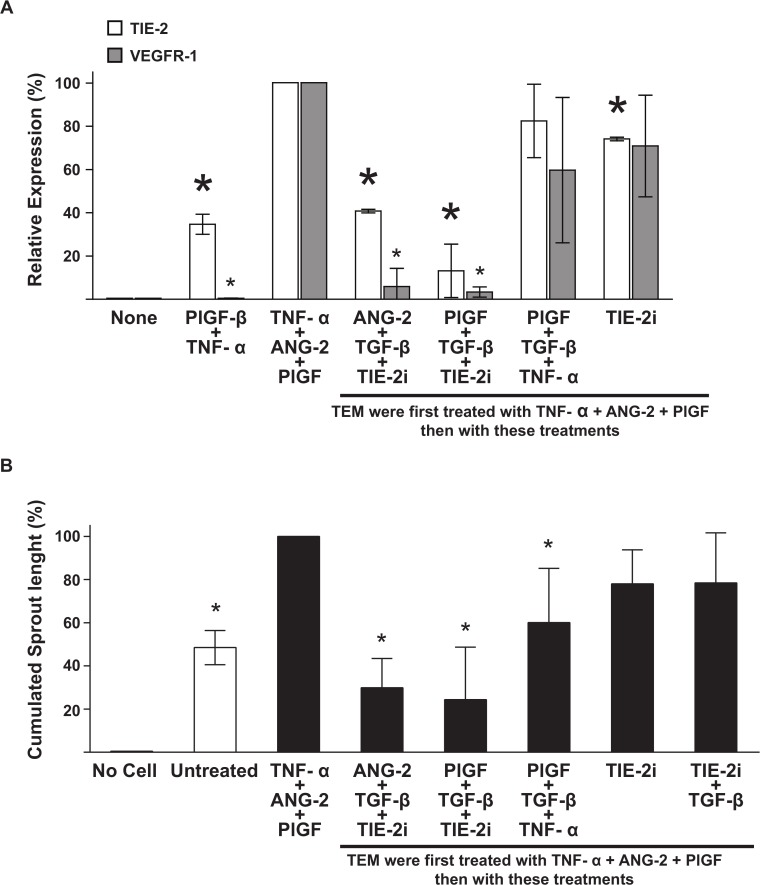
Experimental validation of in silico predicted treatments using ivdTEM.TEM differentiated in vitro were exposed to the treatments predicted in silico and their changes in TIE-2 and VEGFR-1 expression (A) and pro-angiogenic activity (B) measured by flow cytometry and in vitro angiogenesis sprouting assay respectively. The impact of inhibitory treatments was examined on ivdTEM previously treated with TNF-α/PlGF/ANG-2 (panels A and B). Significant variations (P < 0.05) are indicated with an asterisk. In panel A, small and large asterisks referred to VEGFR-1 and TIE-2 expression respectively.